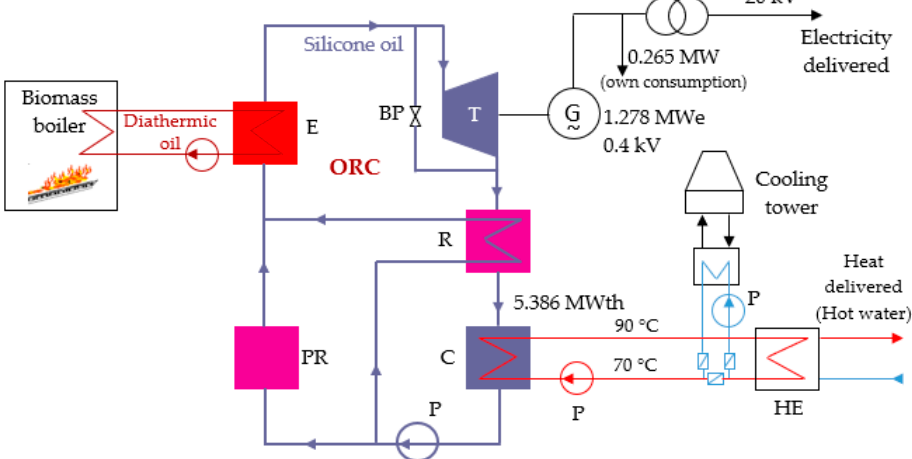
Figure 3. Schematic representation of the CHP plant (E—evaporator; T—turbine; BP—by-pass; G—generator; R—regenerator; C—condenser; PR—preheater; P—pump; HE—heat exchanger).